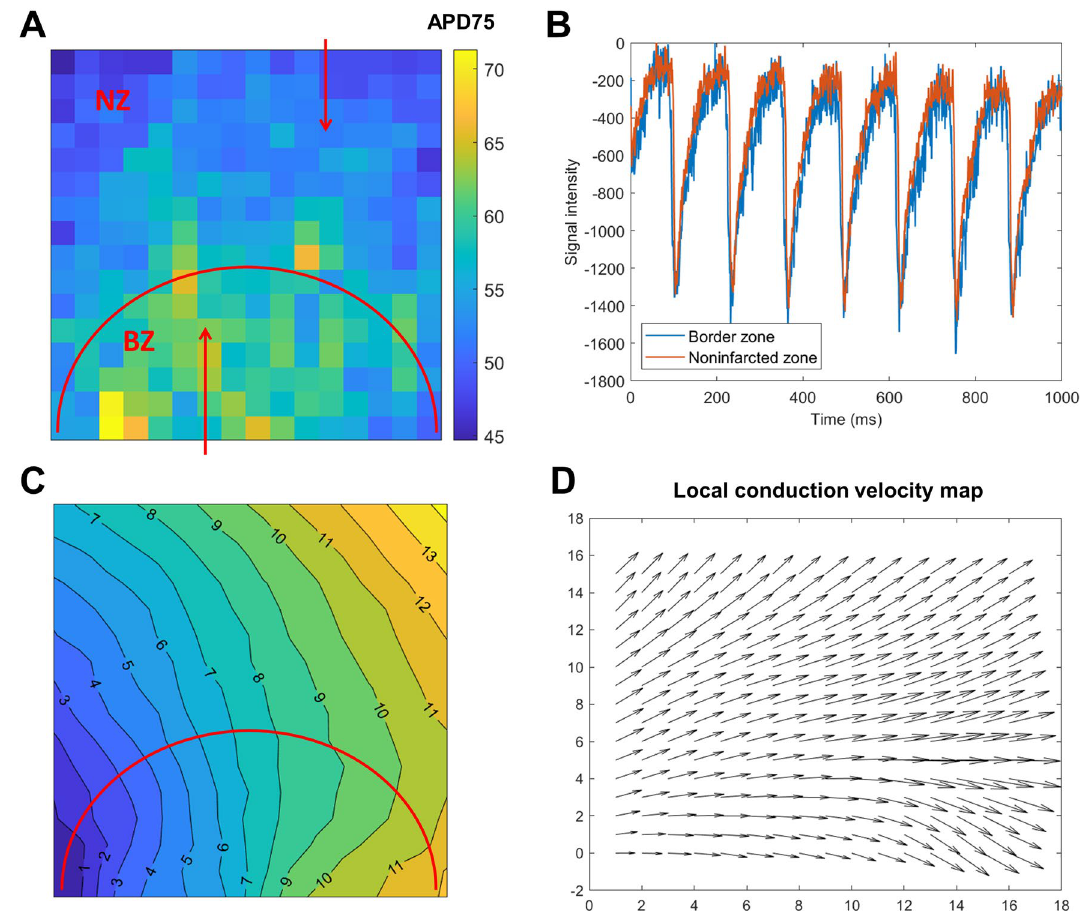
Figure 5. Spatial heterogeneity in rat hearts with a healed infarct. ( A ) A map of AP duration at 80% recovery. The zone under the red semi-circle corresponds to the infarct border zone (BZ), with the zone above the semi-circle being non-infarcted zone. Red arrows point to pixels from which sample traces in the ( B ) panel are extracted. ( B ) Sample traces from border and non-infarcted zone verifying the prolongation of the APs in the border zone (manifesting both earlier depolarization and later depolarization). The traces were scaled to have a similar amplitude and baseline, facilitating visual comparison. ( C ) Average activation map in the same recording. ( D ) Local conduction velocity visualization for panel ( C ), estimated by Bayly’s method 17 , implemented in